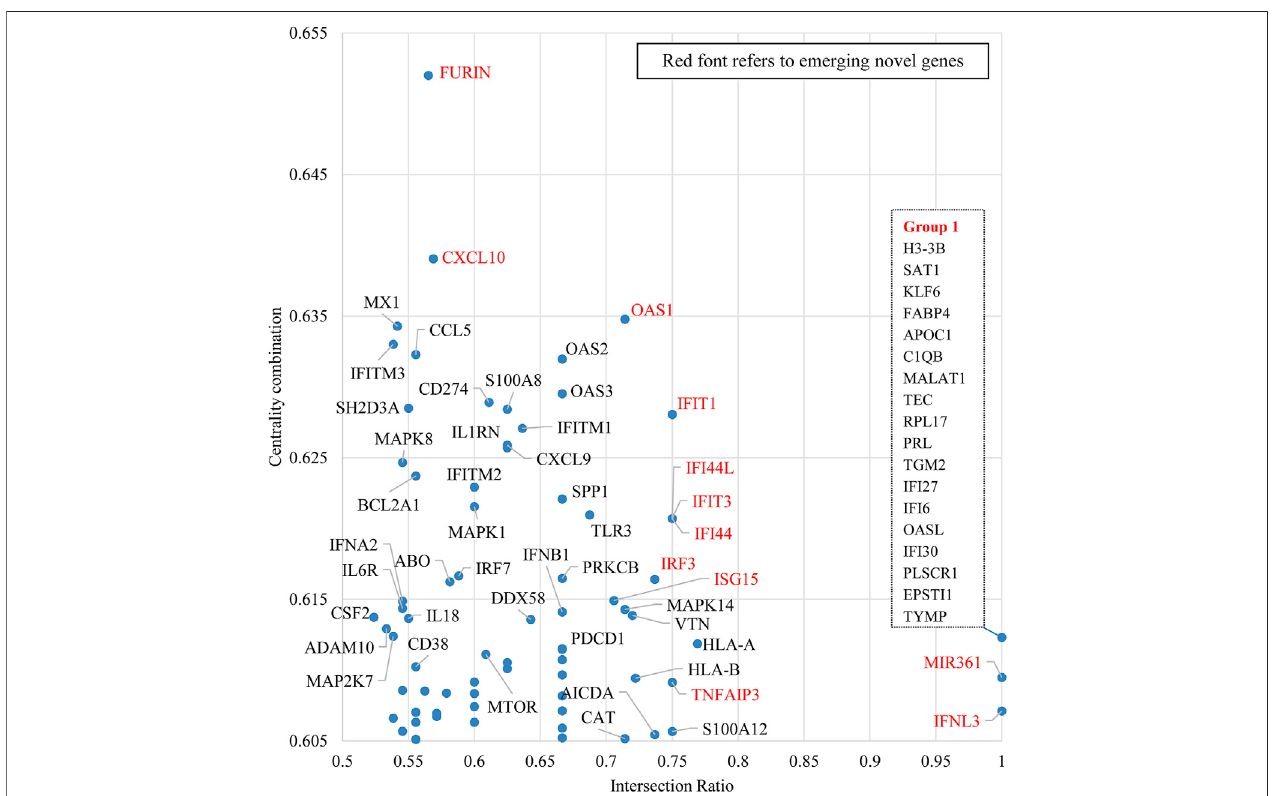
FIGURE 8 | Emerging gene discovery for COVID-19 genetic research – detailed partial view. Note: This fi gure is a zoom-in map for the red broken-line box in Figure 7 .